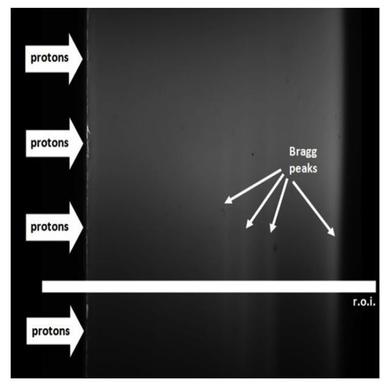
PL image of the multi-component 27 MeV Bragg curve stored in a LiF crystal.